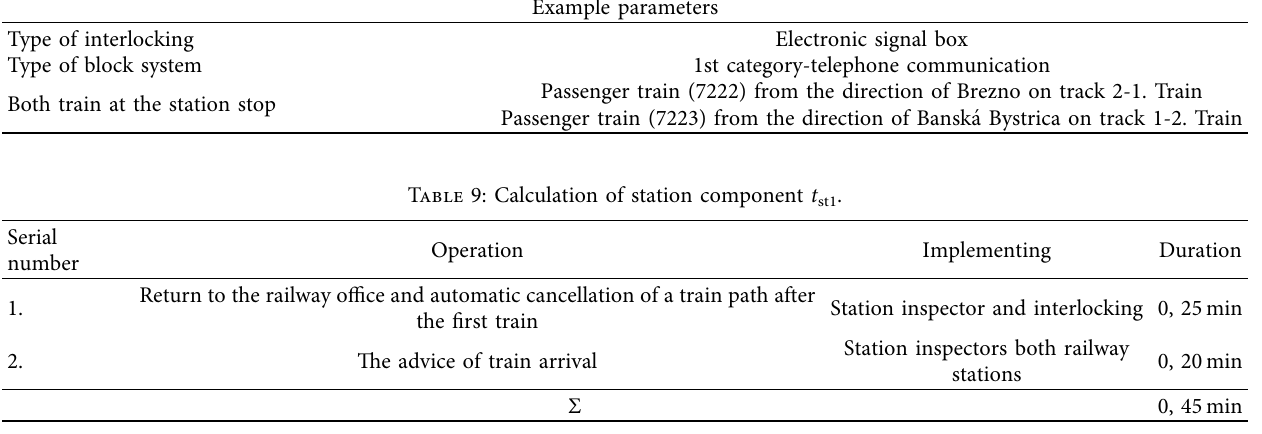
Table 10: Calculation of station component t